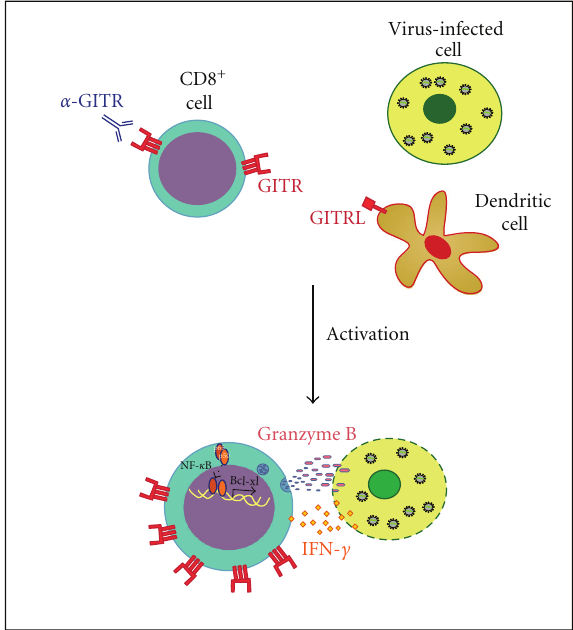
Figure 1: GITR function in antiviral immunity. Treatment with anti-GITR antibody induces activation of CD8 + cells through upregulation of GITR, release of IFN- γ , Granzyme B, and nuclear translocation of NF- κ B with subsequent transcription of target genes. GITRL is expressed in dendritic